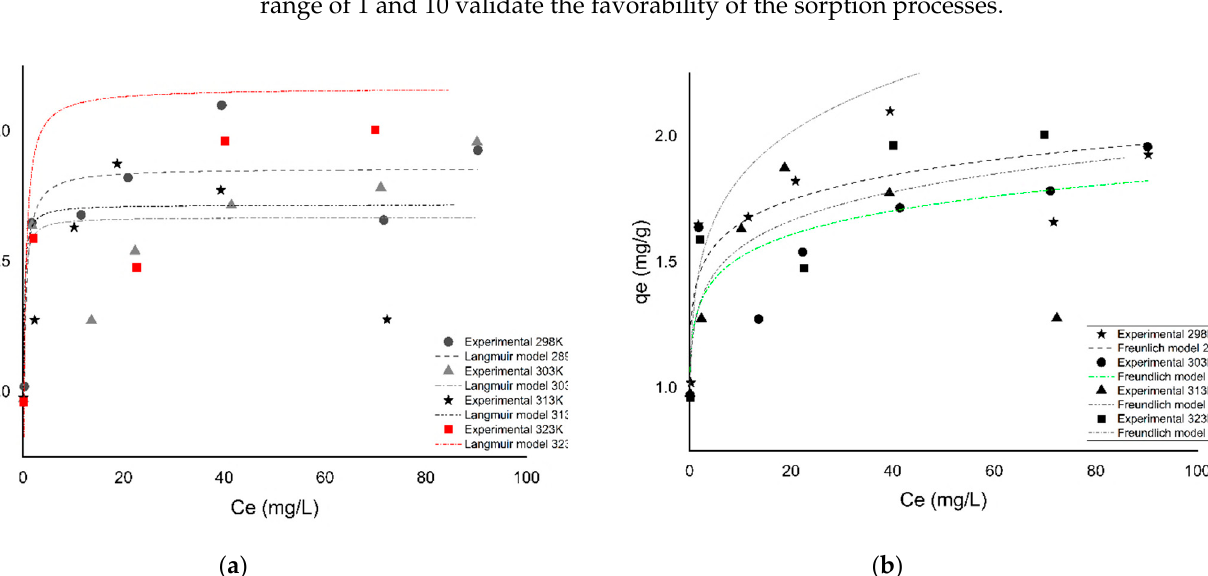
( d ) Figure 10. ( a , b ) As 3+ for Langmuir and Freundlich isotherm model plots; ( c , d ) F − for Langmuir and Freundlich isotherm model plots. Table 5. Non-linearized adsorption isotherm values of F ˉ and As 3+ onto the Fe-pPD composite. Langmuir